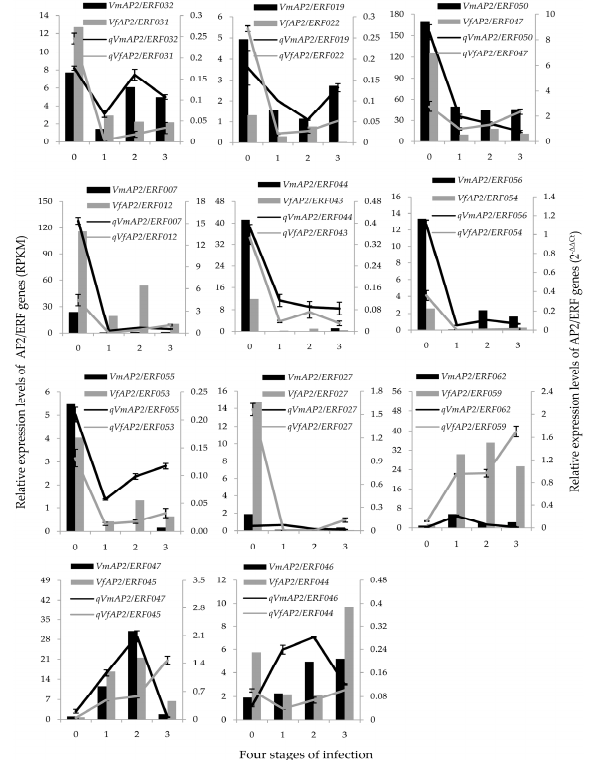
Figure 5. Expression patterns validation of 22 selected AP2/ERF genes in root tissue of Vernicia during the four infection stages. The y ‐ axis represents relative expression level. Primary y ‐ axis represents averaged RPKM values from three biological experiments; secondary y ‐ axis represents the expression levels calculated from qRT ‐ PCR analysis. Each sample was analyzed by real ‐ time PCR in triplicate. The numbers in the x ‐ axis represent the four stages of infection, as follows: 0, uninfected stage; 1, early stage of infection; 2, middle stage of infection; 3, late stage of infection.